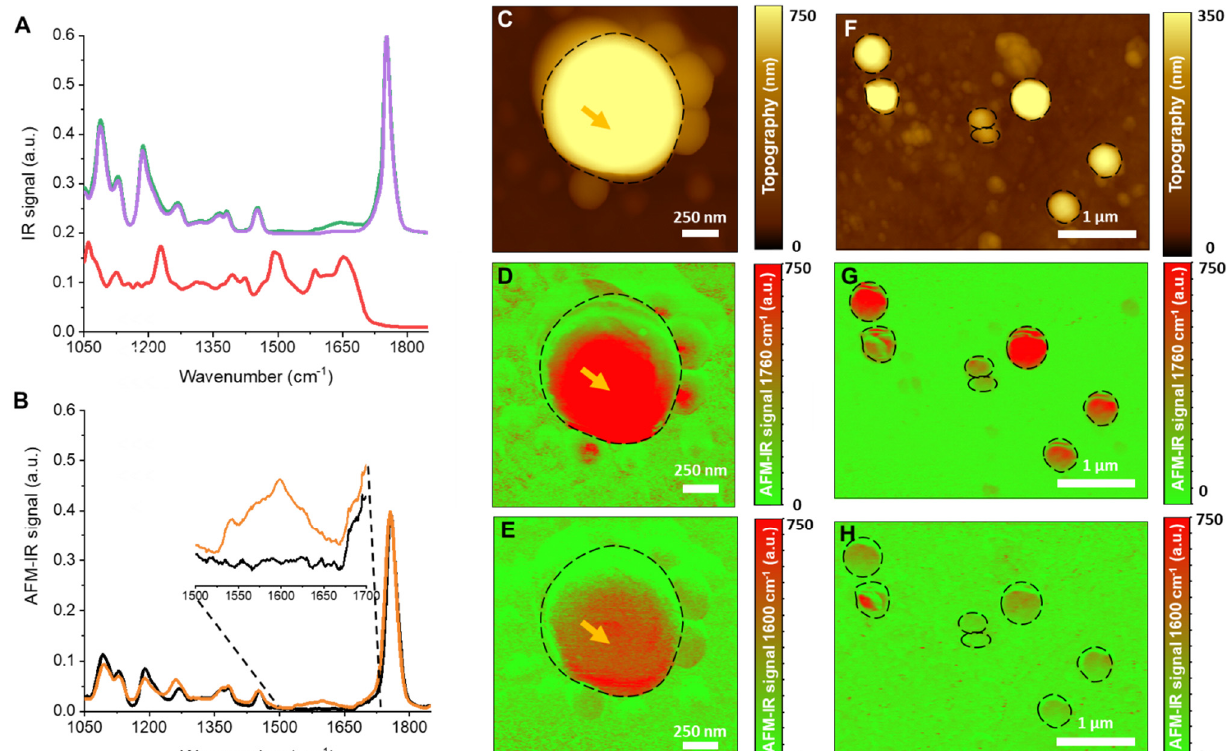
Figure 10. ( A ) ATR-FTIR spectra of VCM (red), empty PLA 8 C NPs (purple), VCM-loaded PLA 8 C NPs (green). ( B ) Local IR spectrum obtained by AFM-IR on empty (black) and VCM-loaded (orange) PLA 8 C NPs at the position indicated with an orange arrow in ( C – E ). ( C , F ) Topography images of PLA NPs. ( D , G ) Tapping AFM-IR map at 1760 cm − 1 corresponding to the strong absorption of PLA. ( E , H ) Tapping AFM-IR map at 1600 cm − 1 corresponding to VCM absorption.